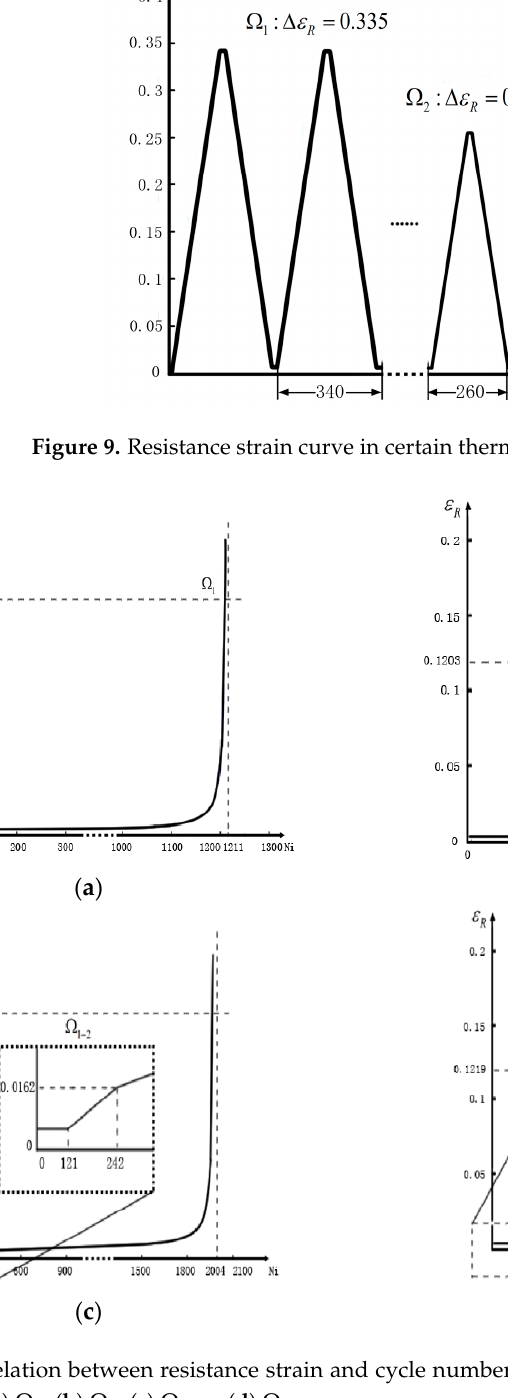
Figure 10. Relation between resistance strain and cycle numbers at T = 298 K under different load